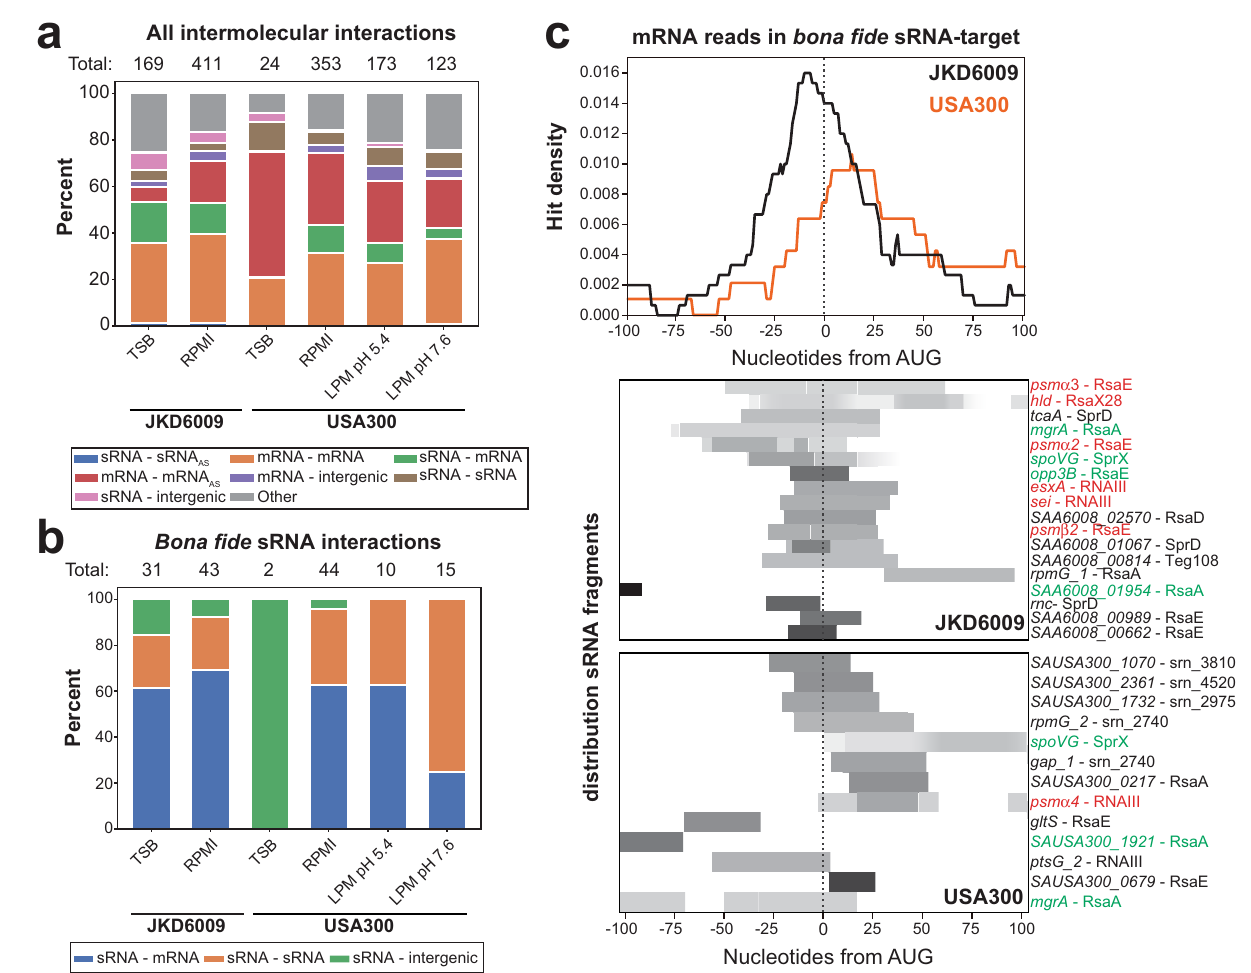
Fig. 3 RNase III CLASH captures canonical sRNA – mRNA interactions. a Categories of identi fi ed intermolecular RNA interactions. Here, a single interaction can be represented by many hybrids. tRNA-tRNA and rRNA-rRNA chimeras were excluded due to their high sequence similarity, meaning that we could not unambiguously determine if these represented intermolecular or intramolecular interactions. “ Total ” indicates the total number of unique RNA-RNA interactions identi fi ed in each dataset. Colour of each stacked bar denotes the type of interaction represented. b As in a , but only for interactions containing a bona fi de sRNA. c Top: distribution of the mRNA fragments in bf sRNA-mRNA interactions around the translational start codon (AUG). Orange line shows data from USA300 and the black line from JKD6009. Bottom: heatmaps showing the read distribution for the mRNA fragments for each individual interaction. Interactions highlighted in green are those that have previously been experimentally veri fi ed, and in red are those interactions involving toxins. Interactions coloured in black are other novel interactions identi fi ed in this